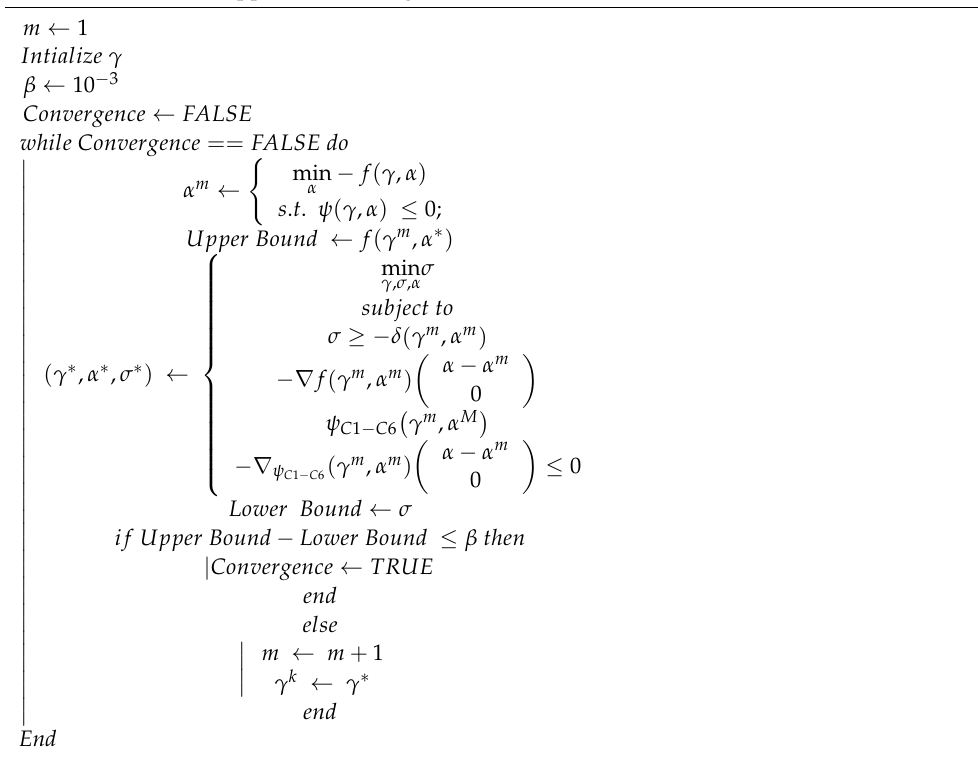
Algorithm 1: Outer Approximation